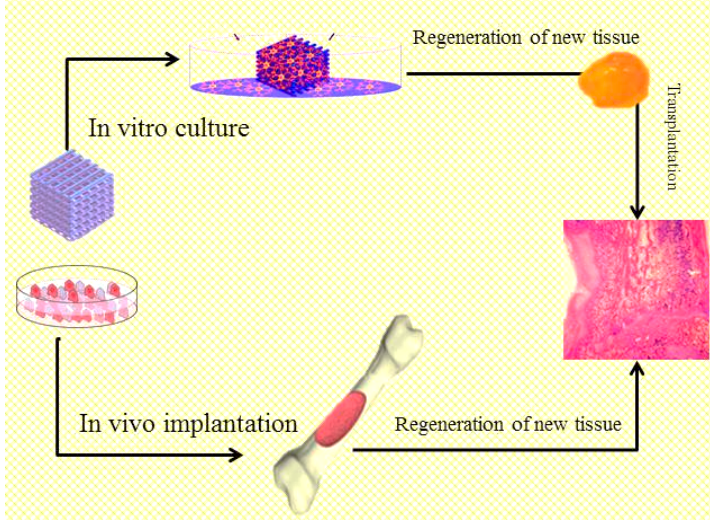
Figure 1. In vitro culture and in vivo implantation of cell-seeded scaffolds to generate new tissue.